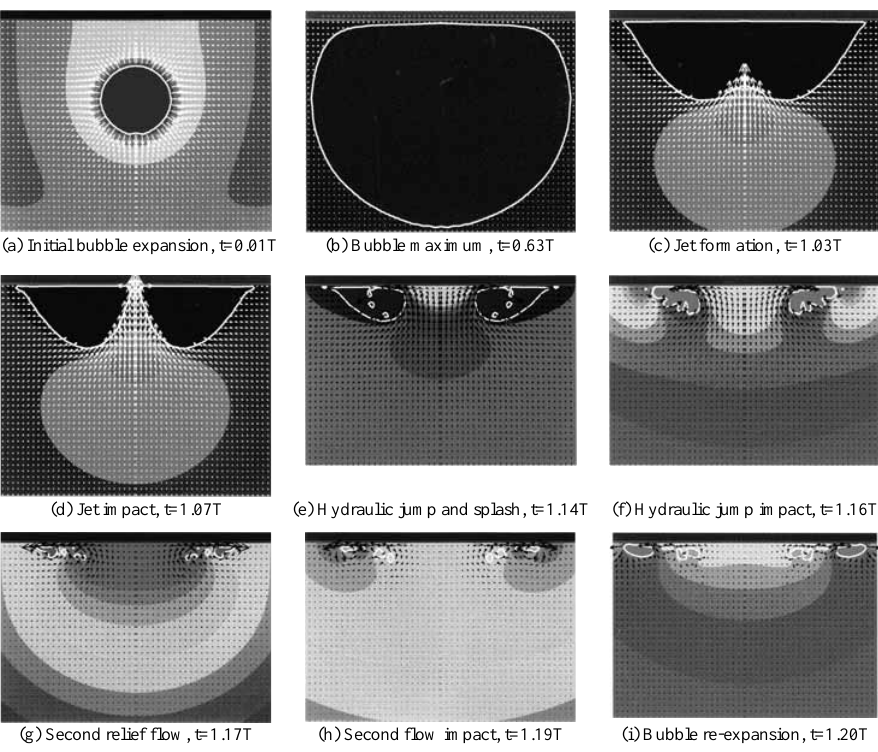
Fig. 3. Bubble shape, fluid velocity and pressure contours in an EITACC